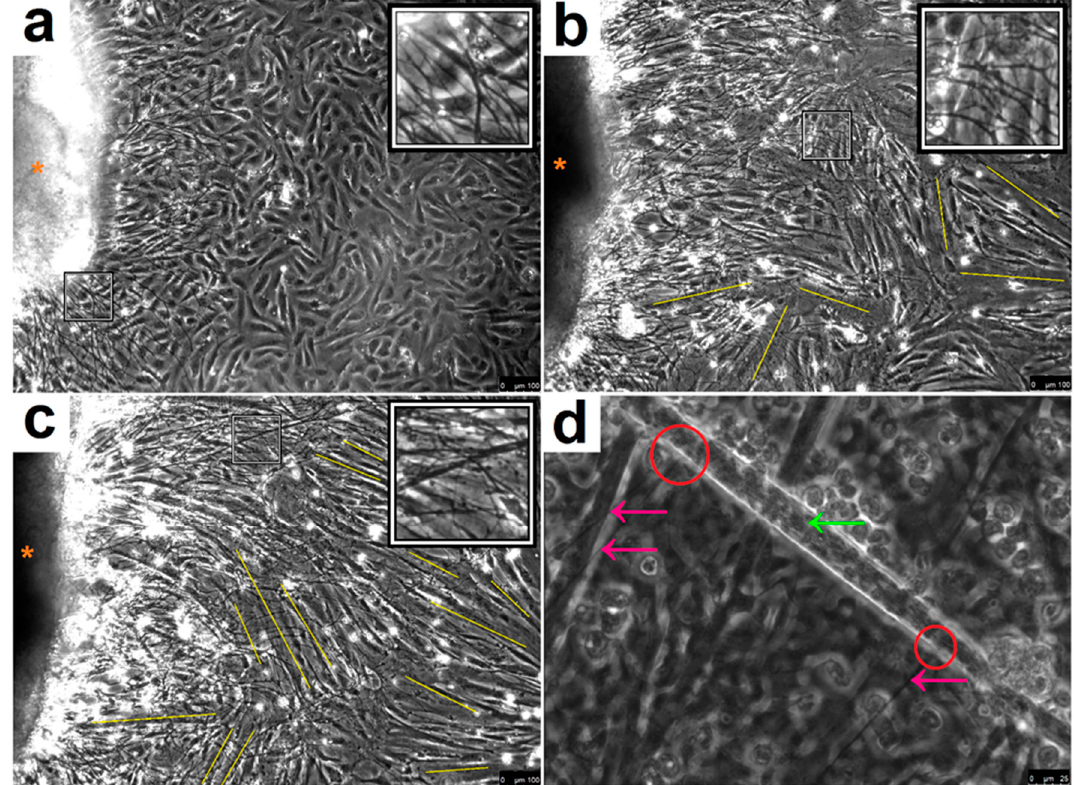
Figure 1. Immortalised human skeletal muscle cells co-cultured with rat embryo spinal cord explants. ( a ) Phase contrast image of explant (orange star) sprouting neurites (shown in enlarged inset) after 24 h over undi ff erentiated myocytes. Image captured at 10x magnification. Scale bar: 100 µ m. ( b ) Multinucleated myotube formation (indicated with yellow lines) after 48 h with continued expansion of neural projections (shown in enlarged inset) emanating from the spinal cord explant (orange star). Image captured at 10x magnification. Scale bar: 100 µ m. ( c ) Maintained neurite growth (shown in inset) and continued myotube formation (yellow lines) at 72 h. Image captured at 10x magnification. Scale bar: 100 µ m. ( d ) Neuronal axons (pink arrows) form a visible link (circled in red) with a myotube (green arrow). Image captured at 40x magnification. Scale bar: 25 µ